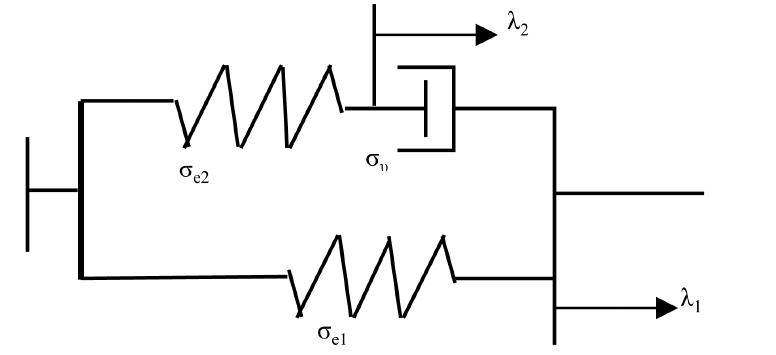
Figure 17. Material model [81].